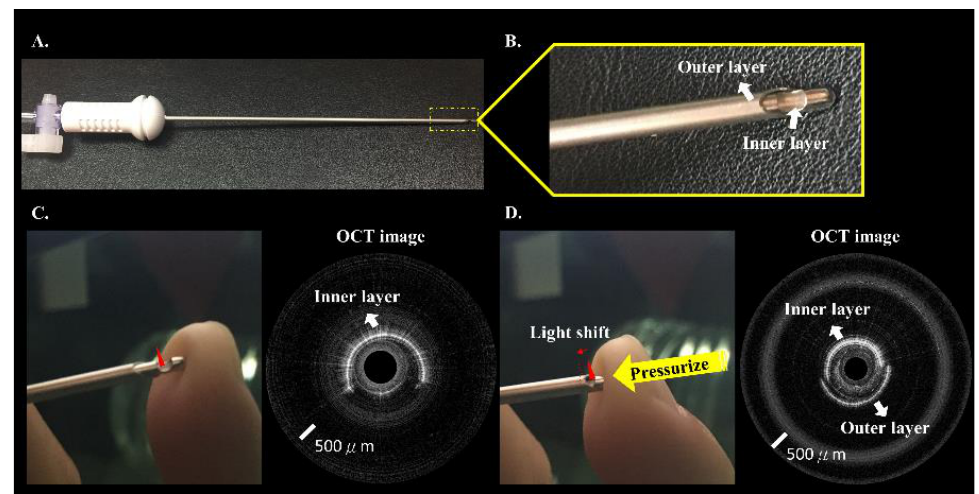
Figure 2. ( A ) Photograph of incorporated Veress needle. ( B ) Enlargement of the yellow area of A. ( C ) Light-spot position of incorporated Veress needle; OCT image of the needle’s inner layer obtained by the OCT system. ( D ) The needle inner and outer layers were simultaneously shown in an OCT image when the light-spot position was shifted due to outside